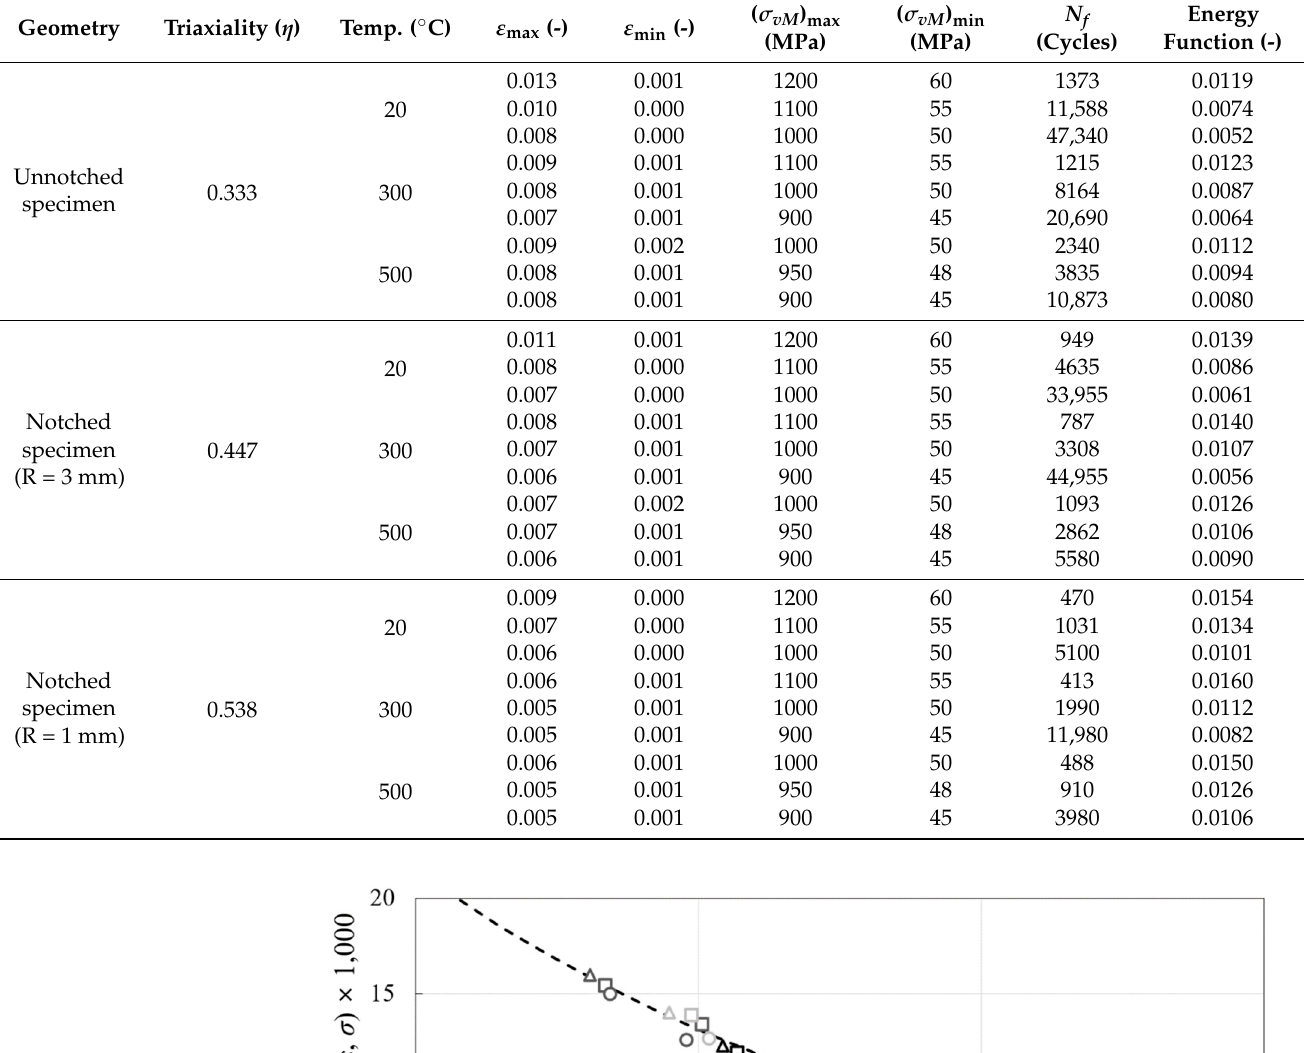
Table 6. Summary of fatigue experiments on the uniaxial and notched specimens.